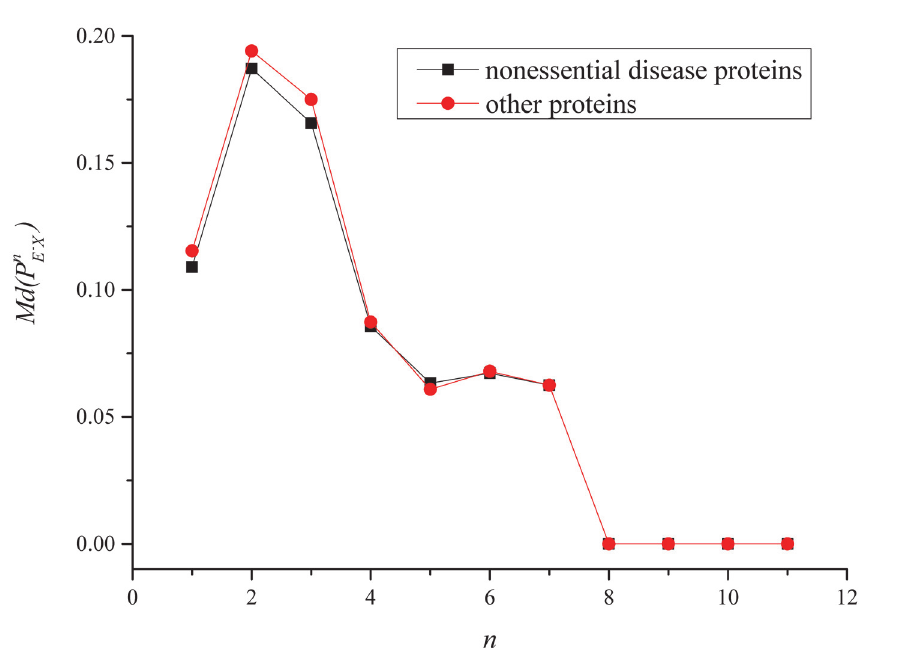
Fig 2. Median values of the proportions of non-disease essential proteins among n ( n 2 {1, 2, ... , 11}) neighbors in the protein interaction network constructed based on the STRING